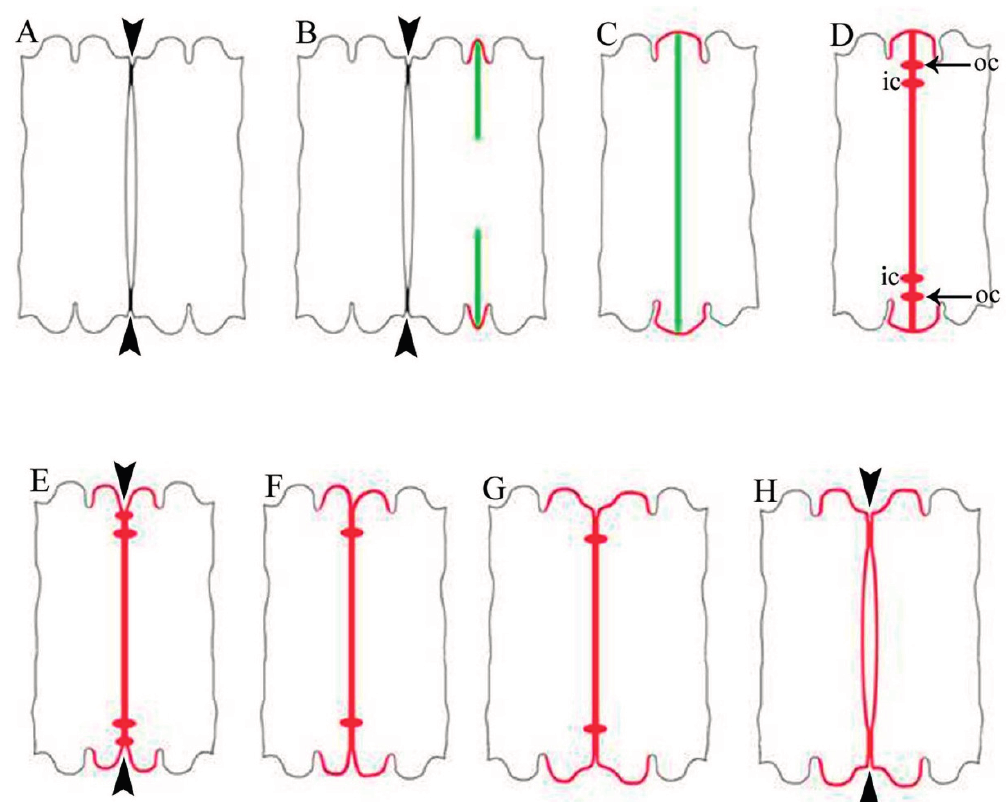
Figure 2. Schematic reconstruction of cytomorphogenesis in Desmidium (cross section). ( A ) Two adult cells connected by primary wall remnants (arrowheads); ( B – D ) Morphogenesis by new wall formation; ( B ) Developing primary wall (red) in the isthmus and outgrowing septum (green); ( C ) The cell halves are fully separated by a septum; ( D ) Outer (oc) and inner (ic) cell wall cylinder are developed perpendicular to the septum; ( E – H ) Morphogenesis by modeling of the newly-formed wall; ( E ) Connecting cell wall has split (arrowhead); ( F ) The outer cylinder has fully split and unfolded; ( G ) The final cell shape is formed at the cell edges; and ( H ) The remaining connecting wall is split and the inner cylinder is unfolded, only the wall (arrowheads) lying between inner and outer cylinder remains, cytomorphogenesis is